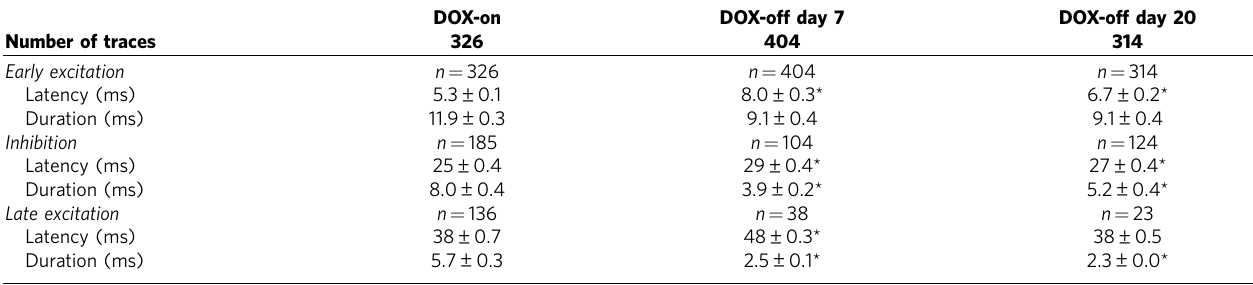
Table 1 | Response parameters of VP neurons to insular cortical stimulation in D2-DTA mice at DOX-on, DOX-off day 7 and 20. Number of traces